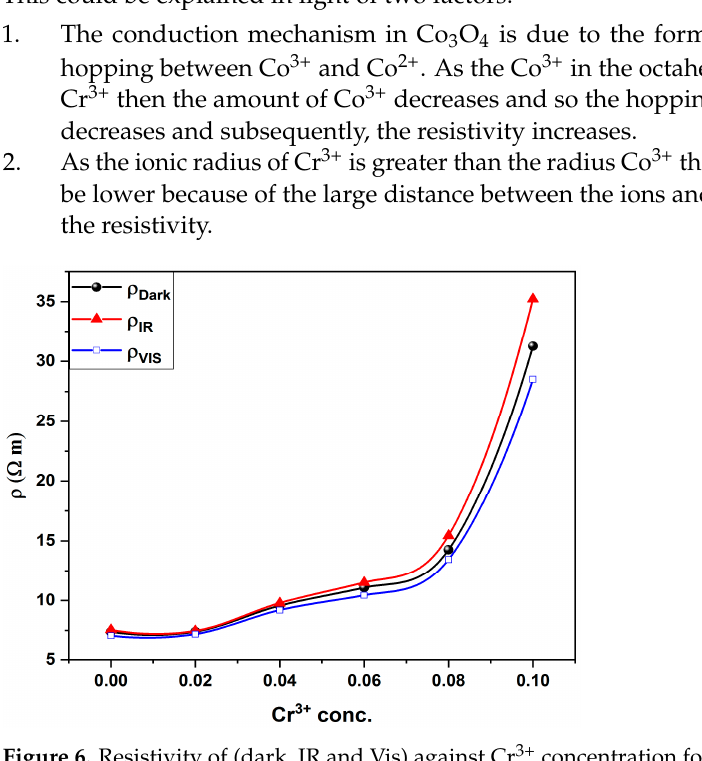
Figure 6. Resistivity of (dark, IR and Vis) against Cr 3+ concentration for all investigated thin films.